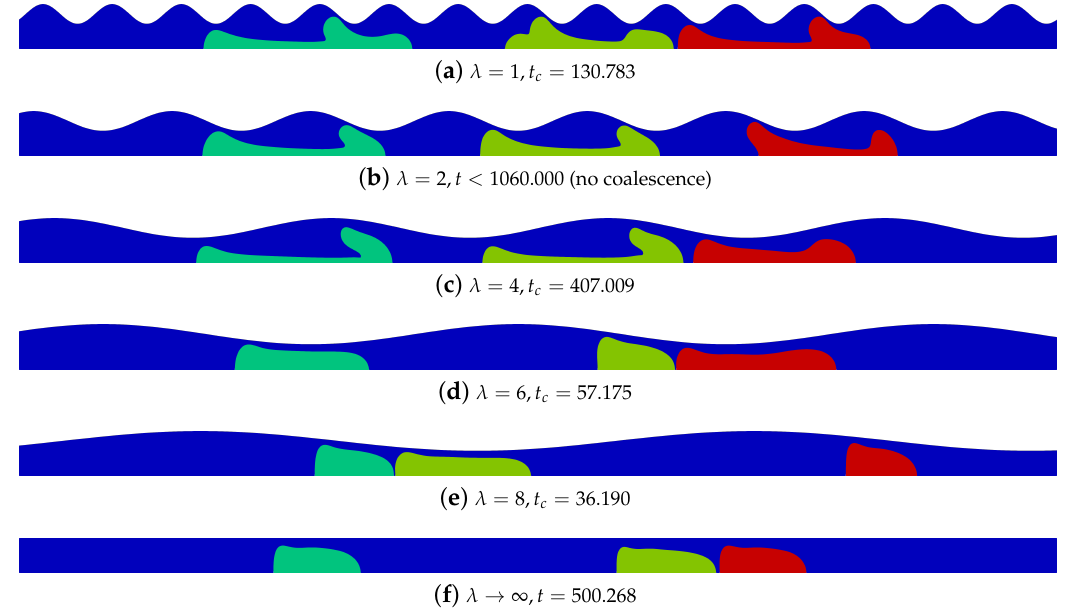
Figure 12. Slug flow of three consecutive drops in channels with amplitude A = 0.14, drop size factor κ d = 1.72, wavelength λ = { 1,2,4,6,8, ∞ } , and initial slug length s = 1.375. For subfigure ( e ), wavelength λ = 8 in the rear and center drops coalesces in time t c = 36.190, while in the others the coalescence takes place between the center and front drops. It is also noted that in subfigure ( b ) at wavelength λ = 2 no coalescence took place in time t < = 1060.000.